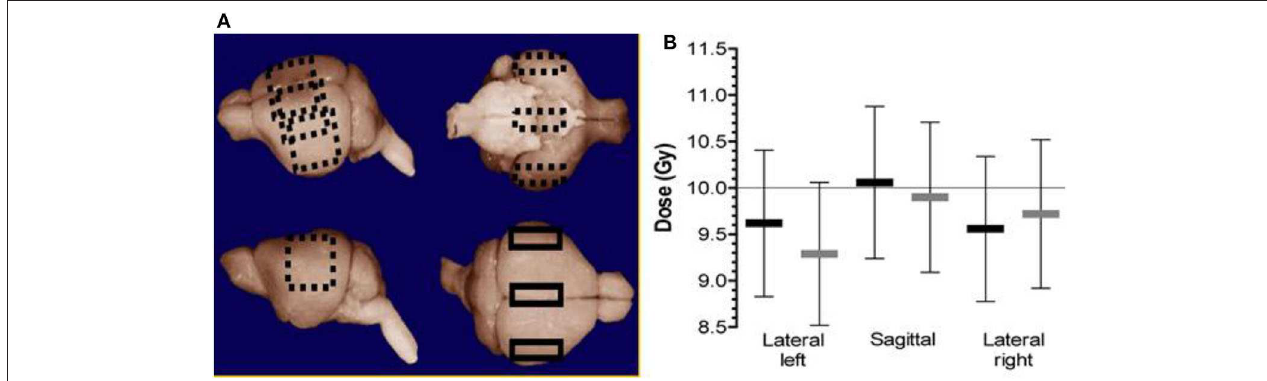
FIGURE 8 | (A) The three different positions where the TLDs were placed inside the brain of a mouse cadaver (sagittal/center, lateral left, and right). (B) The measured dose at different points. The black markers represent 10Gy delivered in a single pulse of 1.8 us (FLASH). The light gray markers represent the dose delivered at a dose-rate of 0.1 Gy/s (i.e., conventional dose-rate). Error bars represent the relative uncertainty in the absorbed dose measurements ( ± 8.2% in each case) [15]. Reprinted from “Irradiation in a flash: Unique sparing of memory in mice after whole brain irradiation with dose rates above 100 Gy/s,” Vol 124/Issue 3, Figure 1 , Copyright (2017), with permission from Elsevier.